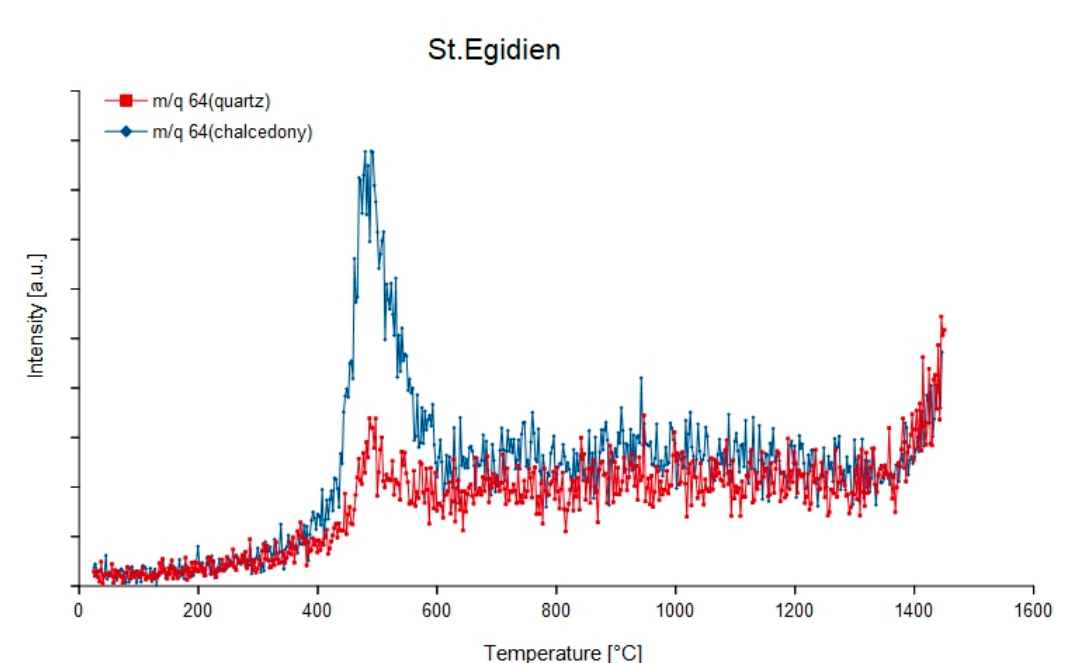
Figure 13. Degassing curves of quartz and chalcedony from the agate sample St. Egidien, Germany at mass-charge ratio 64 ( 32 S 16 O 2 ).